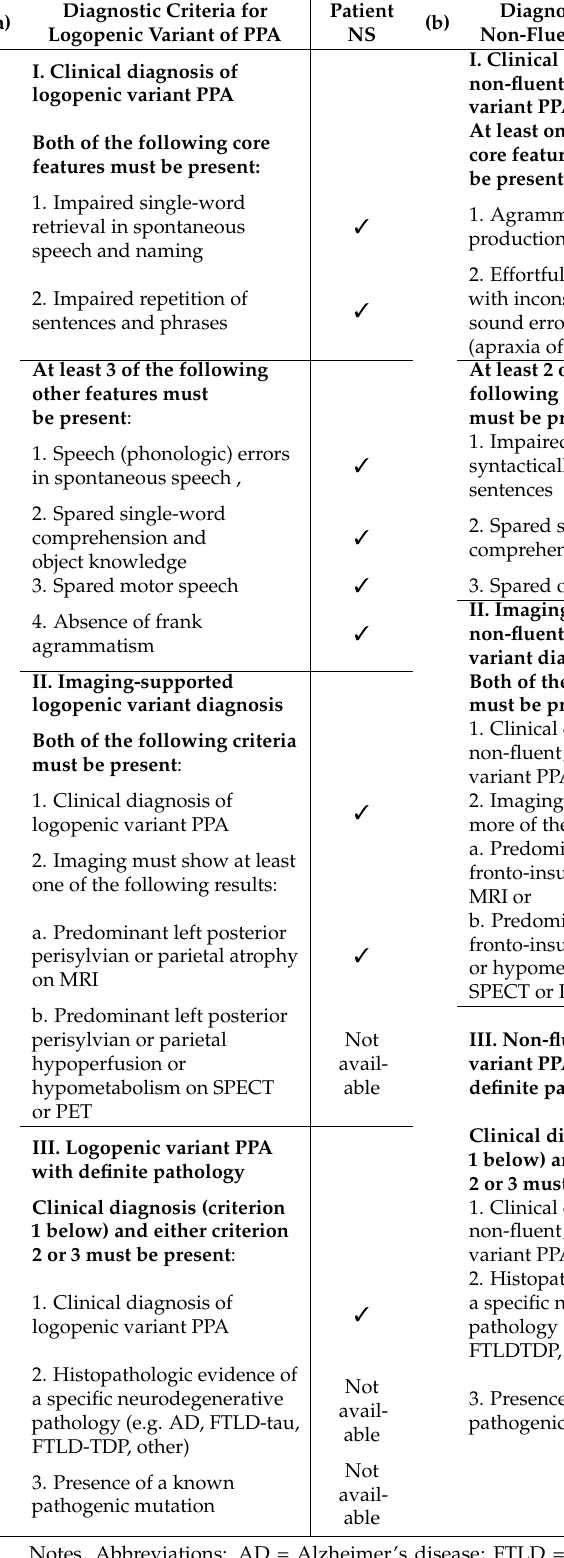
Table 3. ( a – c ) PPA patients according to the Gorno-Tempini, Hillis [1] international consensus criteria of primary progressive